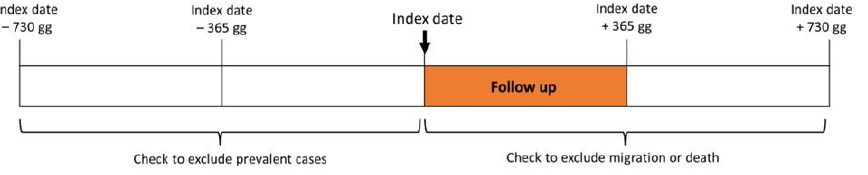
Figure 1. Time windows for the identification of the cohort.